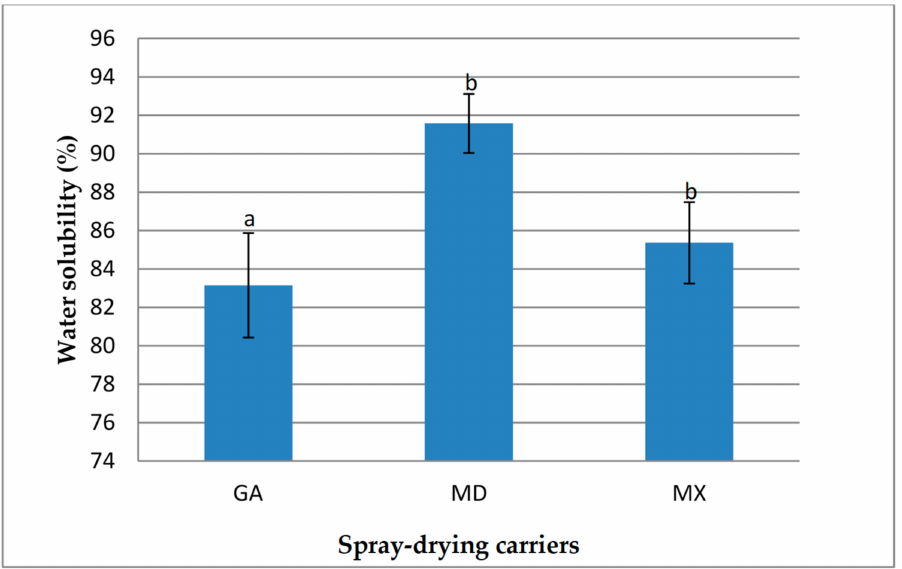
Figure 9. Water solubility (%) of different lemongrass leaves extract powders using different spray-drying carriers. All data are the mean ± SD of three replicates. Values with different letters are significantly different ( p ≤